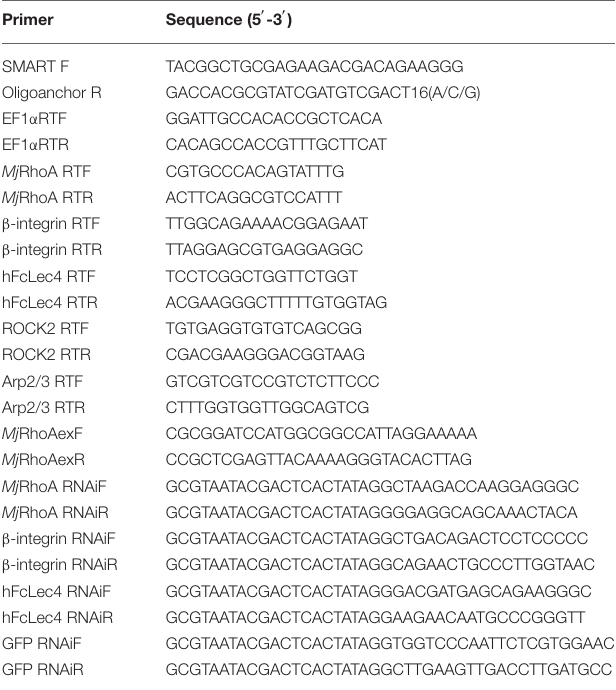
TABLE 1 | Primers used in this